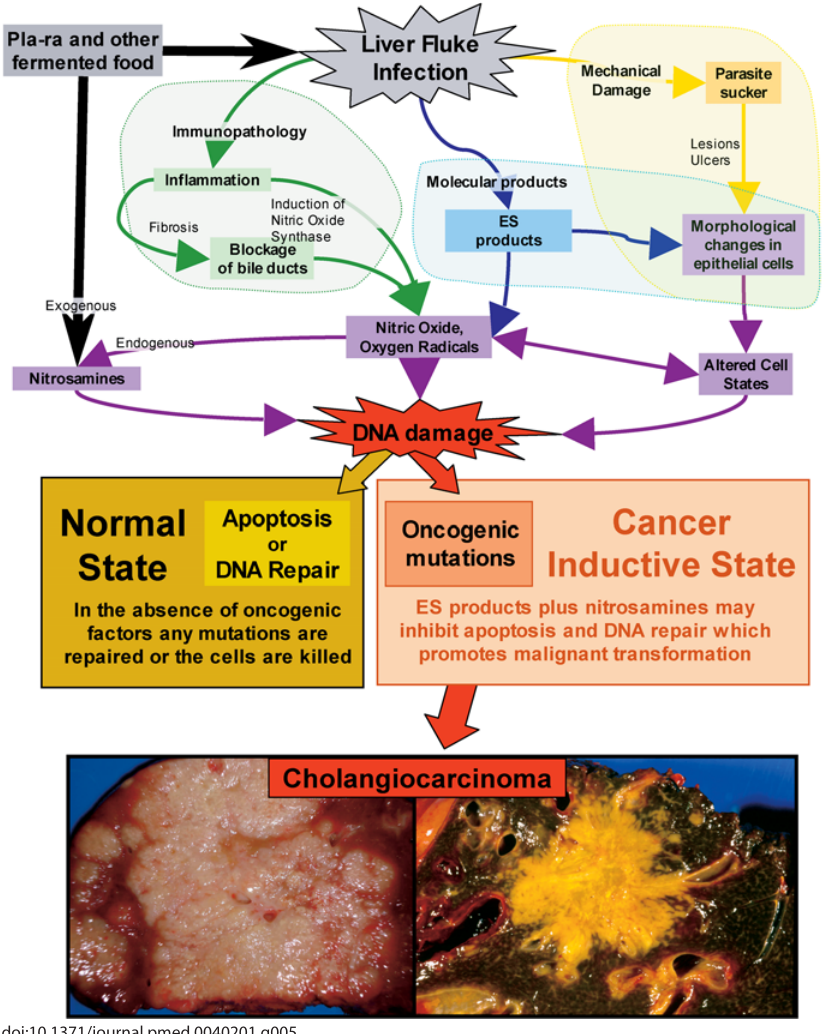
Figure 5. Proposed Mechanisms of Opisthorchis -Derived CCA Initiation The three proposed pathways linking the parasite to CCA initiation are mechanical damage (in yellow), molecular products (in blue), and immunopathology (in green). Combined, these mechanisms result in several common elements (purple) that all lead to DNA damage. The inhibition of a normal DNA damage response is the fi nal oncogenic factor proposed to dramatically increase the likelihood of a malignant transformation. This invariably leads to progression of CCA. (Adapted from [10].) The photographs underneath the schematic show two livers with advanced